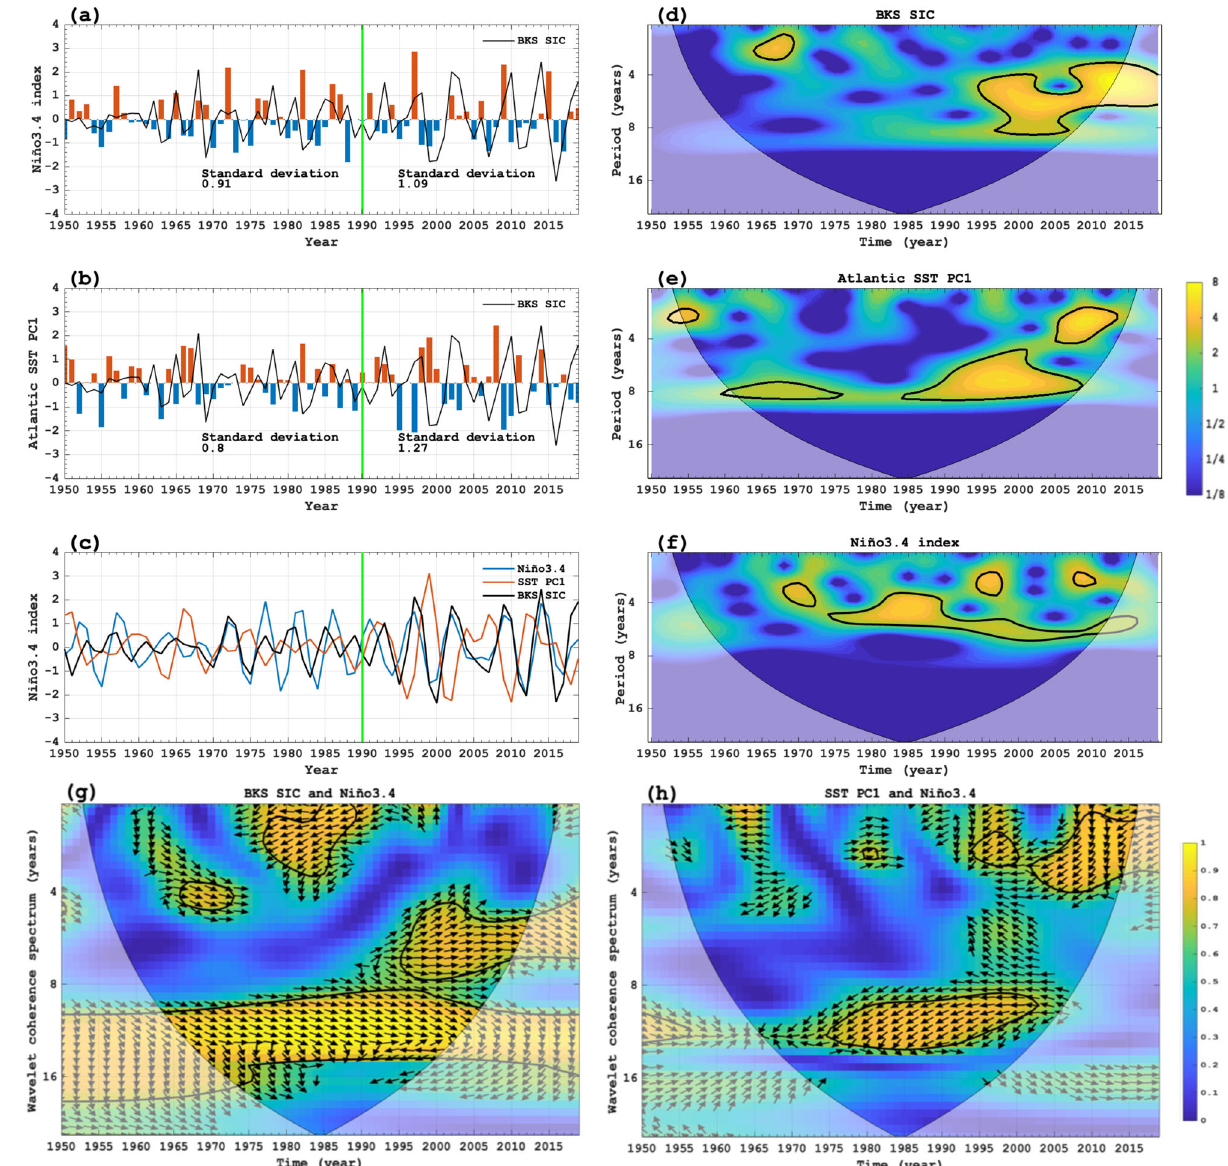
Fig. 2 | Wavelet power spectra and coherence spectra of the temporal varia- tions of the winter sea ice concentration (SIC) over Barents-Kara Seas (BKS), North Atlantic sea surface temperature (SST) and Niño3.4 index. a , b Normalized time series of a 9-yearhigh-pass fi ltered DJF (December-February) mean Niño3.4 index (bars) and b the fi rst principal component (PC1, bars) of